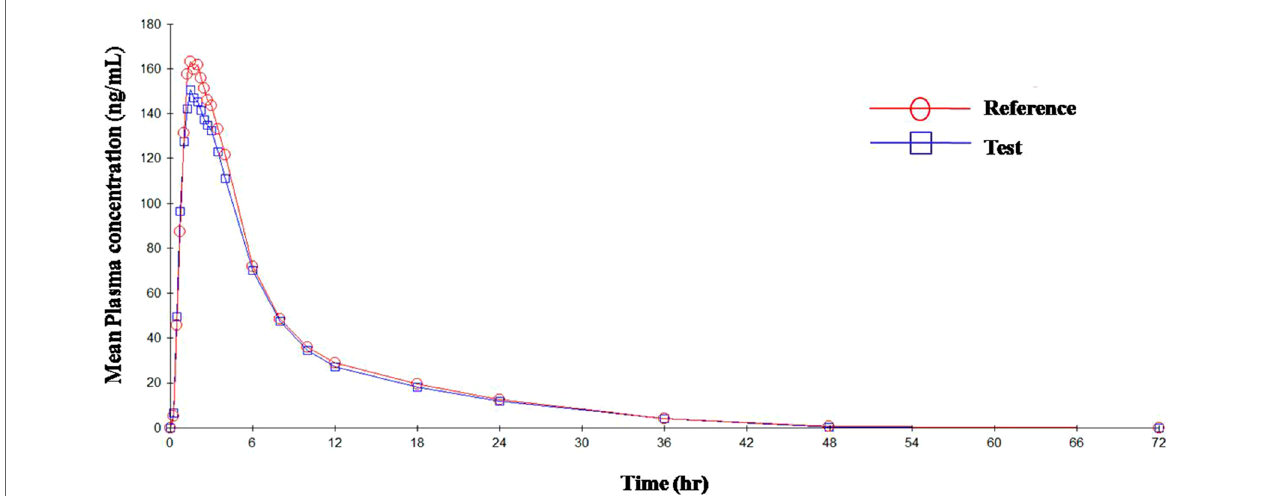
FIGURE 4 | Mean plasma concentration vs. time curve for HCTZ after administration of single dose of test and reference